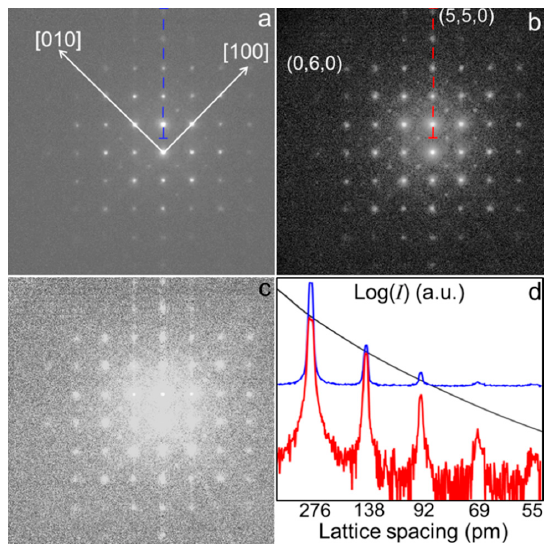
Figure 2. Intensity-rescaling on SrTiO 3 (100) electron diffraction (ED)-pattern: ( a ) Raw experimental nano-diffraction pattern (logarithmic scale); ( b ) sup{I(s)} rescaled pattern; ( c ) difference between patterns shown in (a) and (b); ( d ) comparison in a logarithmic scale between the line profile along the dashed blue line in (a) (blue curve) and along the dashed red line in (b) (red curve) after rescaling. Black curve is the corresponding profile of sup{I(s)} × I max constraint.